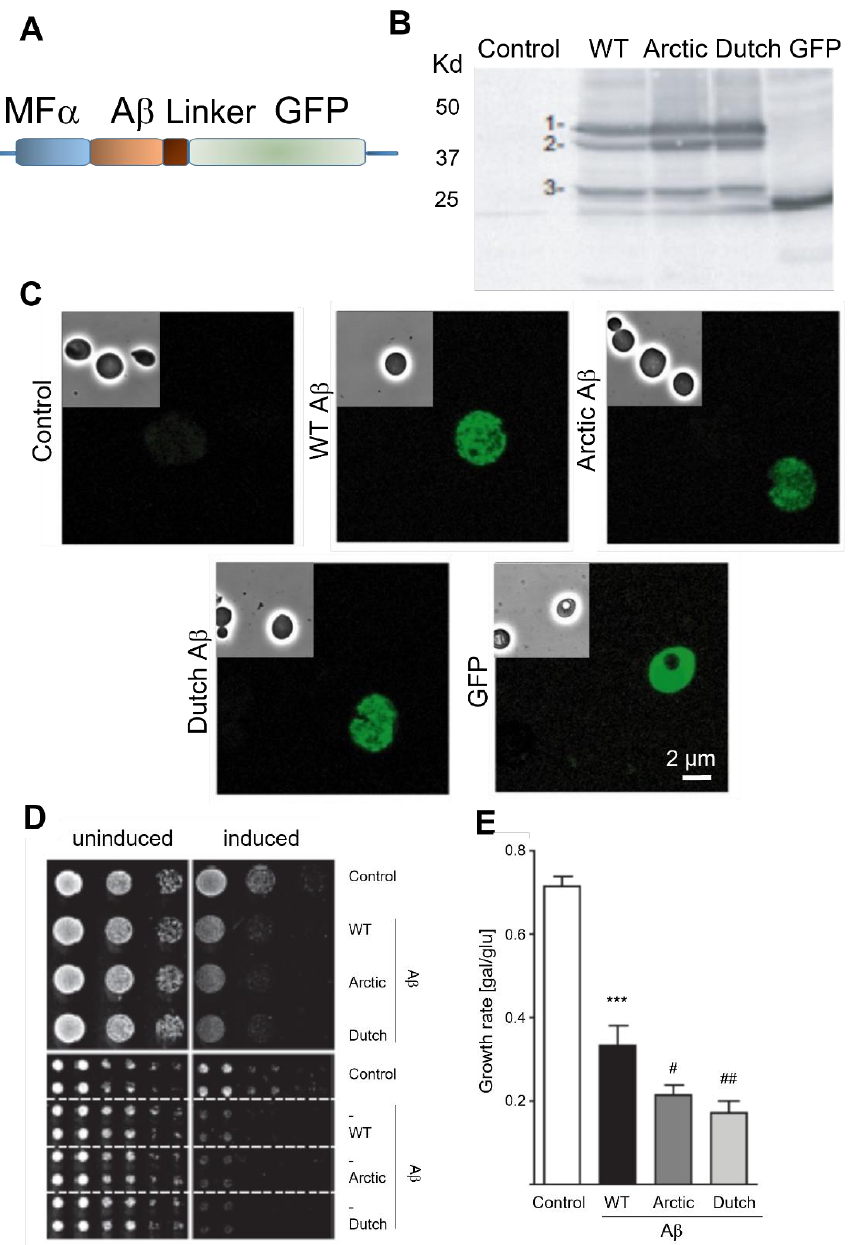
Figure 2. Expression of A β 1–42 and its effect in yeast. ( A ) A β 1–42 construct contains the mating factor α (MF α ) pre-pro-leader sequence secretion signal at the N-terminal and a GFP tag at the C-terminal fused with a gly-ala linker (in brown). ( B , C ) Western blot analysis of A β 1–42 -GFP expression using an anti-GFP antibody ( B ) and representative A β 1–42 -GFP confocal images ( C ) in yeast transformed with wild-type (WT), Dutch or Arctic A β 1–42 or with an empty vector (control) and cultured for 6 h at 30 ◦ C in inducing (galactose) medium. A strain constitutively expressing GFP was used as a positive control. Glycosylated MF α -A β 1–42 -GFP is labelled as 1, non-glycosylated MF α -A β 1–42 -GFP is marked as 2 and A β 1–42 -GFP corresponds to 3. ( D ) Serial dilutions of yeast transformed with WT, Dutch or Arctic A β 1–42 or with an empty vector (control) and spotted on inducing (galactose) and non-inducing (glucose) medium for 3 days at 30 ◦ C. ( E ) Quantification of mean growth calculated after 3 days in inducing medium divided by the growth in non-inducing medium (Gal/Glu). Data are the mean ± SEM of 11–16 experiments. *** p < 0.001 vs. control, ## p < 0.01, # p < 0.05 vs. WT by ANOVA plus Bonferroni as post hoc